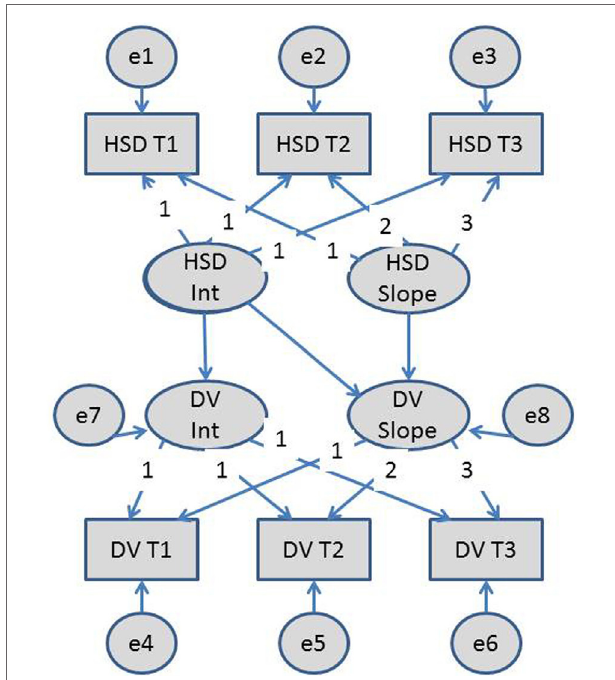
FigUre 1 | Parallel process analysis of home–school dissonance (HSD) latent growth model predicting a dependent latent growth